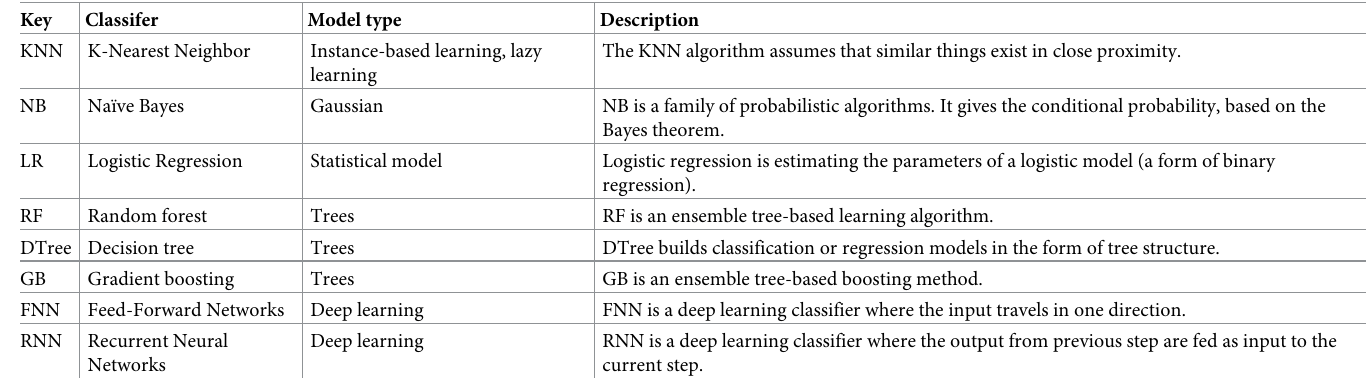
Table 4. List of baseline classifiers.